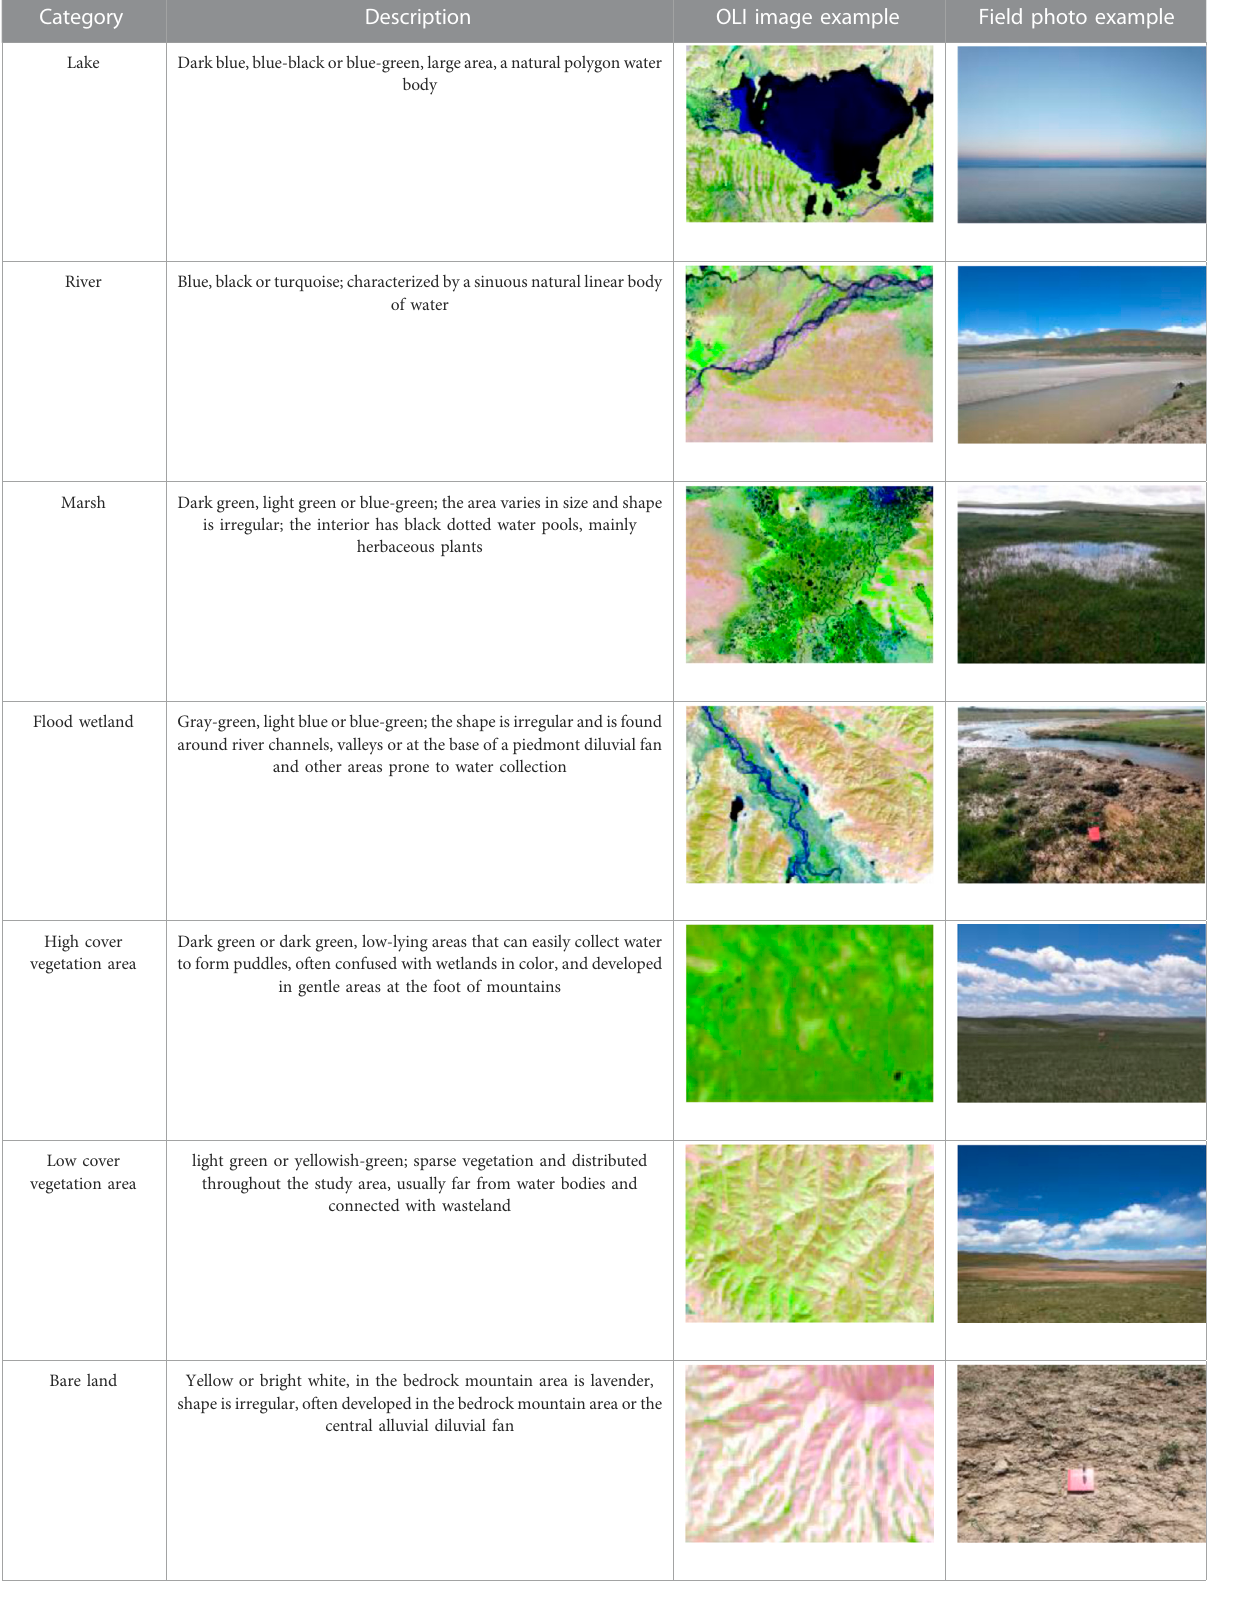
TABLE 2 Wetlands and land cover types categories as seen in a Landsat eight OLI color composite (bands 7, 5, 3) and fi eld